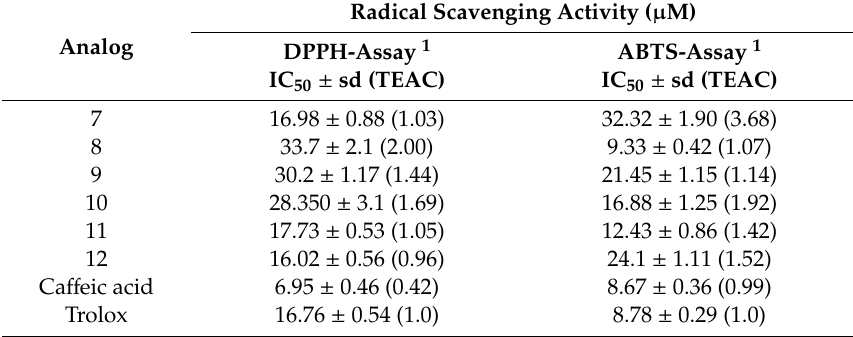
Table 2. Free radical-scavenging activity of N , N (cid:48) -dialkyl-9,9-biacridylidenes derivatives measured by DPPH and ABTS assay, respectively. Experiments were performed in triplicate. Results were expressed as IC 50 ± standard deviation or TEAC